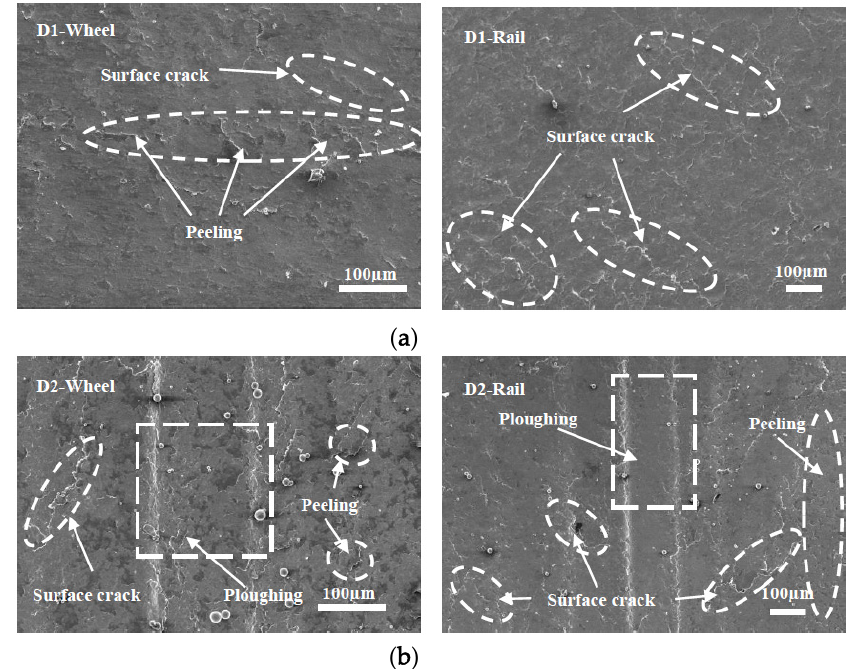
Figure 13. Micrographs of the worn surfaces of the wheel and rail rollers at room temperature. ( a ) D1; ( b ) D2.